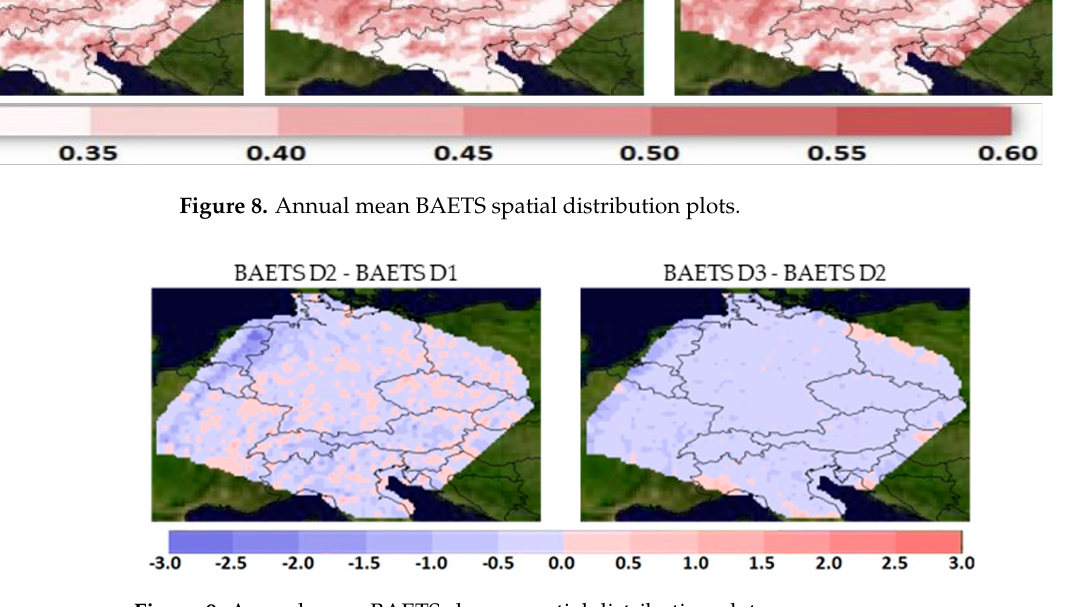
Figure 9. Annual mean BAETS change spatial distribution plots. Table 7. Annual mean BAETS.